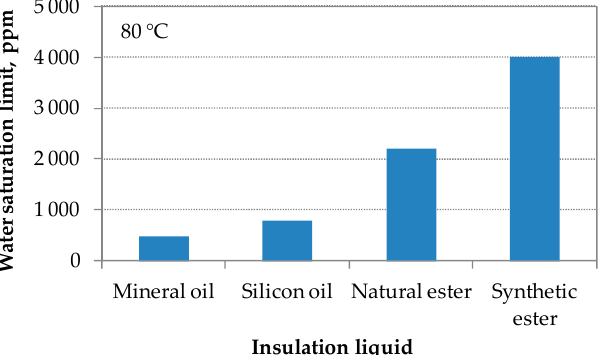
Figure 1. Comparison of water saturation limit for different electro-insulating liquids at 80 ° C; based on [17].